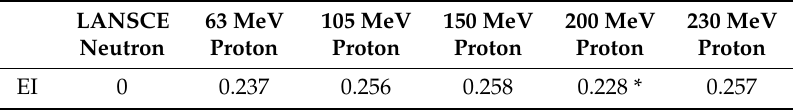
Table 3. EI for LET in layer structure with SiGe.